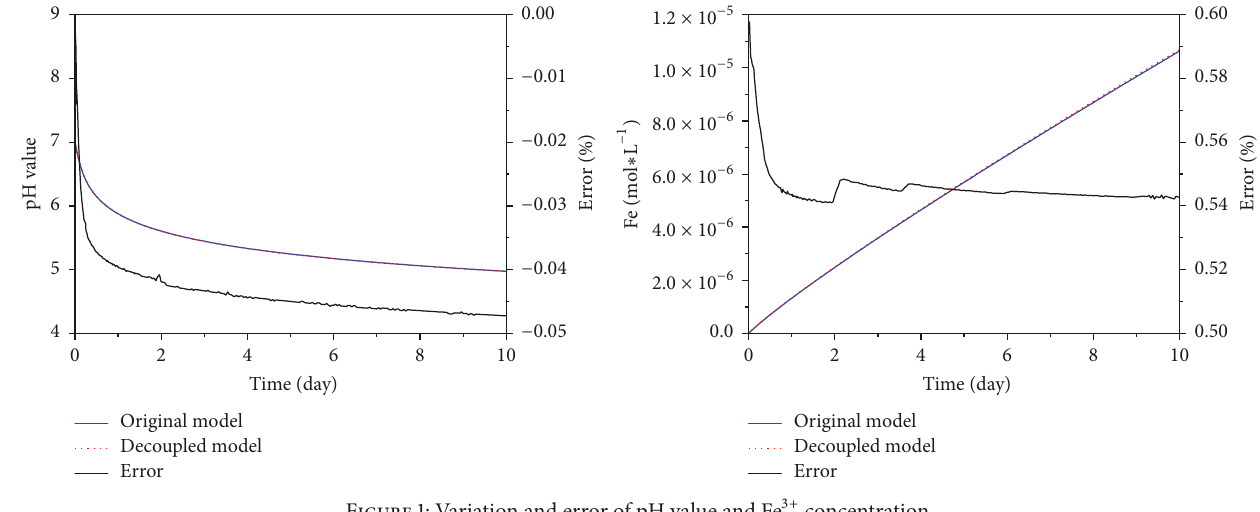
Figure 1: Variation and error of pH value and Fe 3+ concentration. Table 3: Parameters for the 1D and 2D models.